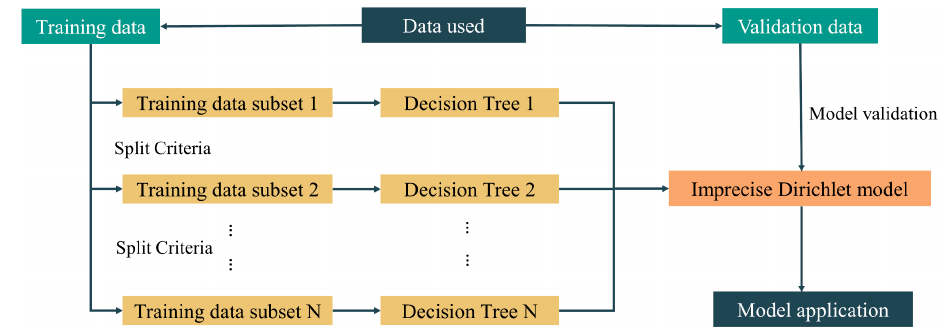
Figure 4. Credal Decision Tree learning process: training and validating.